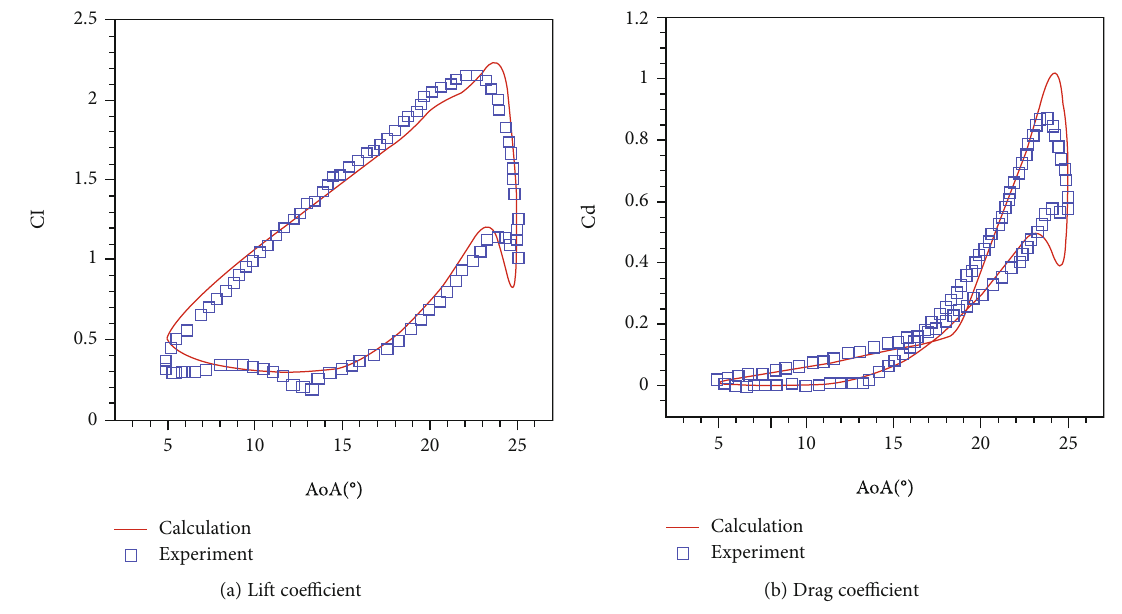
Figure 3: Lift and drag coe ffi cient distributions of a NACA0012